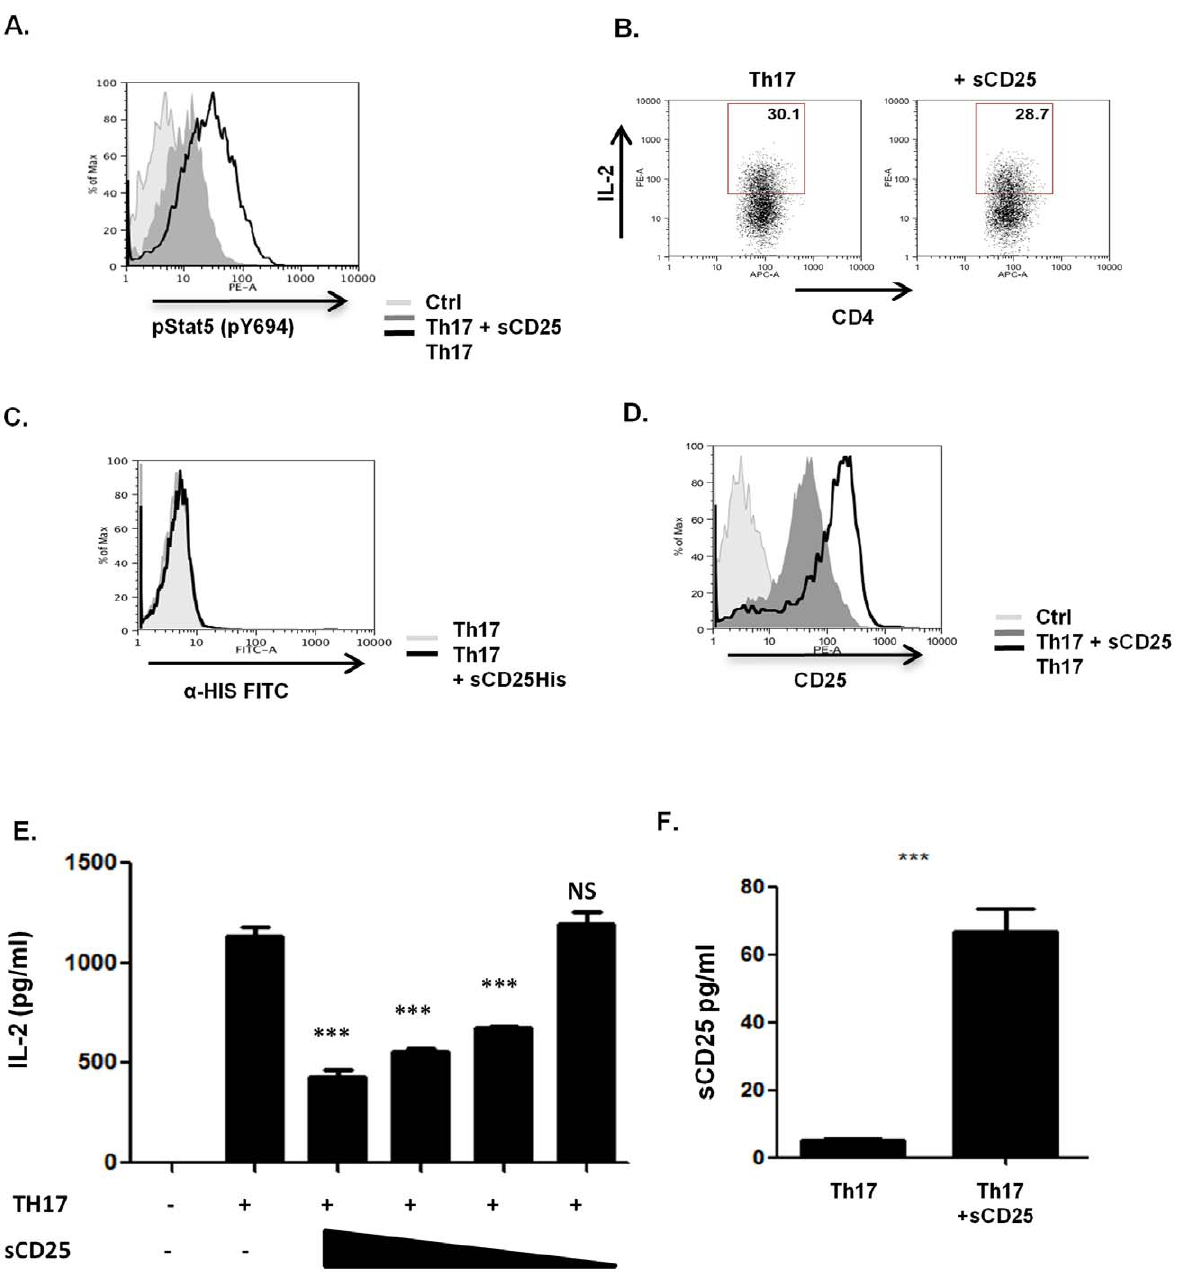
Figure 5. sCD25 inhibits IL-2R signalling by sequestering secreted IL-2. ( A–D ) Purified naive CD4 + T cells activated for 24 hrs under Th17 inducing conditions in the presence or absence of sCD25 and examined for levels of ( A ) p-Stat5 pY694, ( B ) intracellular IL-2 expression ( C ) surface binding of sCD25-His and ( D ) surface expression of endogenous CD25 by FACS analysis. ( E ) Levels of secreted IL-2 detected by ELISA 24 hours after Th17 activation in the presence of decreasing doses of sCD25 (20,10,5,1 m g/ml). ( F ) Levels of IL-2/sCD25 complex in the supernatants of Th17 cells activated for 24 hours in the presence or absence of sCD25 (20 m g/ml). Data shown as mean + / 2 standard deviation from triplicate experiments. All data are representative of at least 3 independent experiments. Statistical Significance determined by unpaired student’s t-test, ***p #